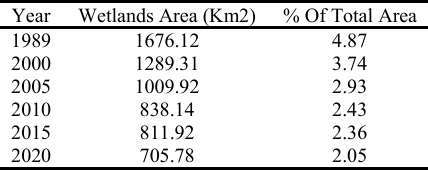
Table 3 . Areal coverage of wetlands in NWBD